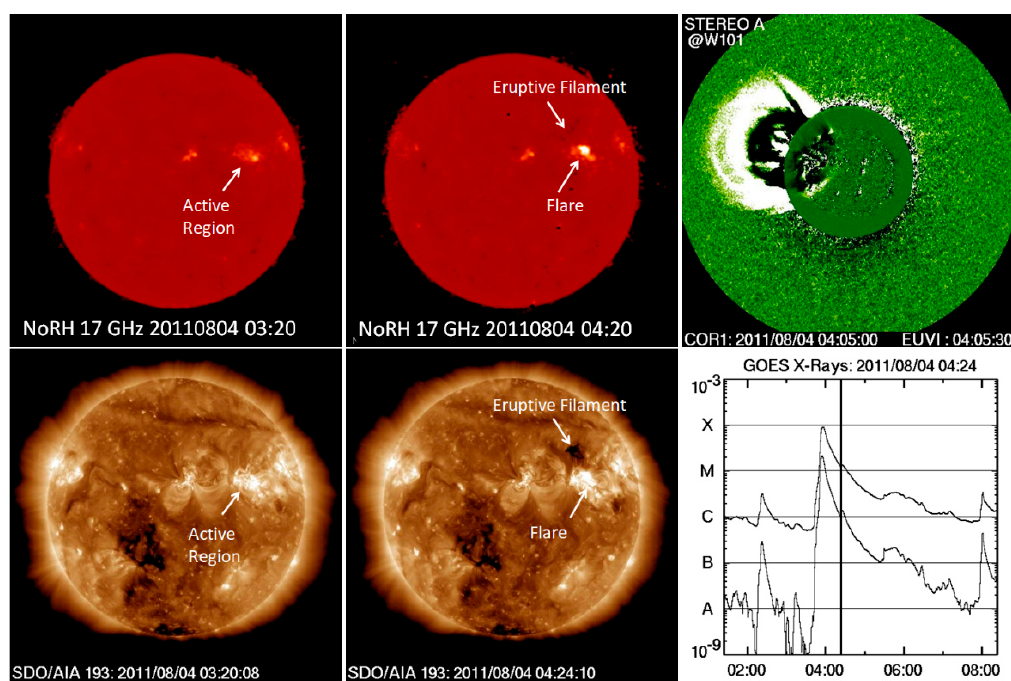
Figure 7. Information similar to that in Figure 6, but for the 2011 August 4 eruptive event involving a major flare. (top row ) The Nobeyama Radioheliograph (NoRH) image at 03:20 UT shows the active region NOAA 11261 (N16W51) before the eruption. The 04:20 UT image shows the flare brightening in microwaves and the eruptive filament from the source active region. The associated CME is shown in a STEREO/COR1 image with a superposed EUV image ( top right ) showing the disturbance on the disk. ( bottom row ) The SDO/AIA images in the lower panels show the flare and filament eruption from the active region. The bright, compact PEA (marked “Flare”) shows up as an M9.3 flare in the GOES light curve.